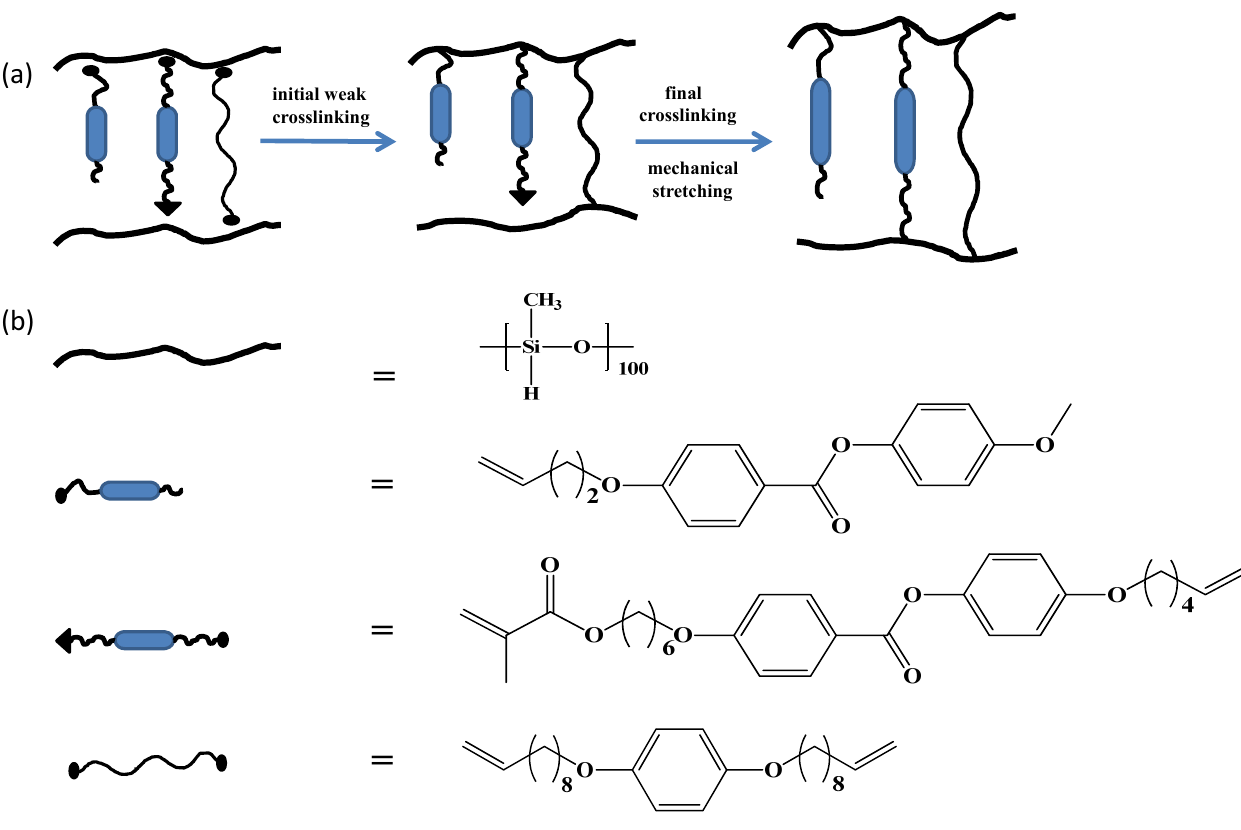
Figure 4. ( a ) Schematic representation of synthetic strategy proposed by Küpfer and Finkelmann, for the synthesis of monodomain nematic Liquid-Crystalline Elastomers (LCEs); ( b ) chemical structures of polymer chain, LC monomer and crosslinkers used for the synthesis monodomain nematic LCEs